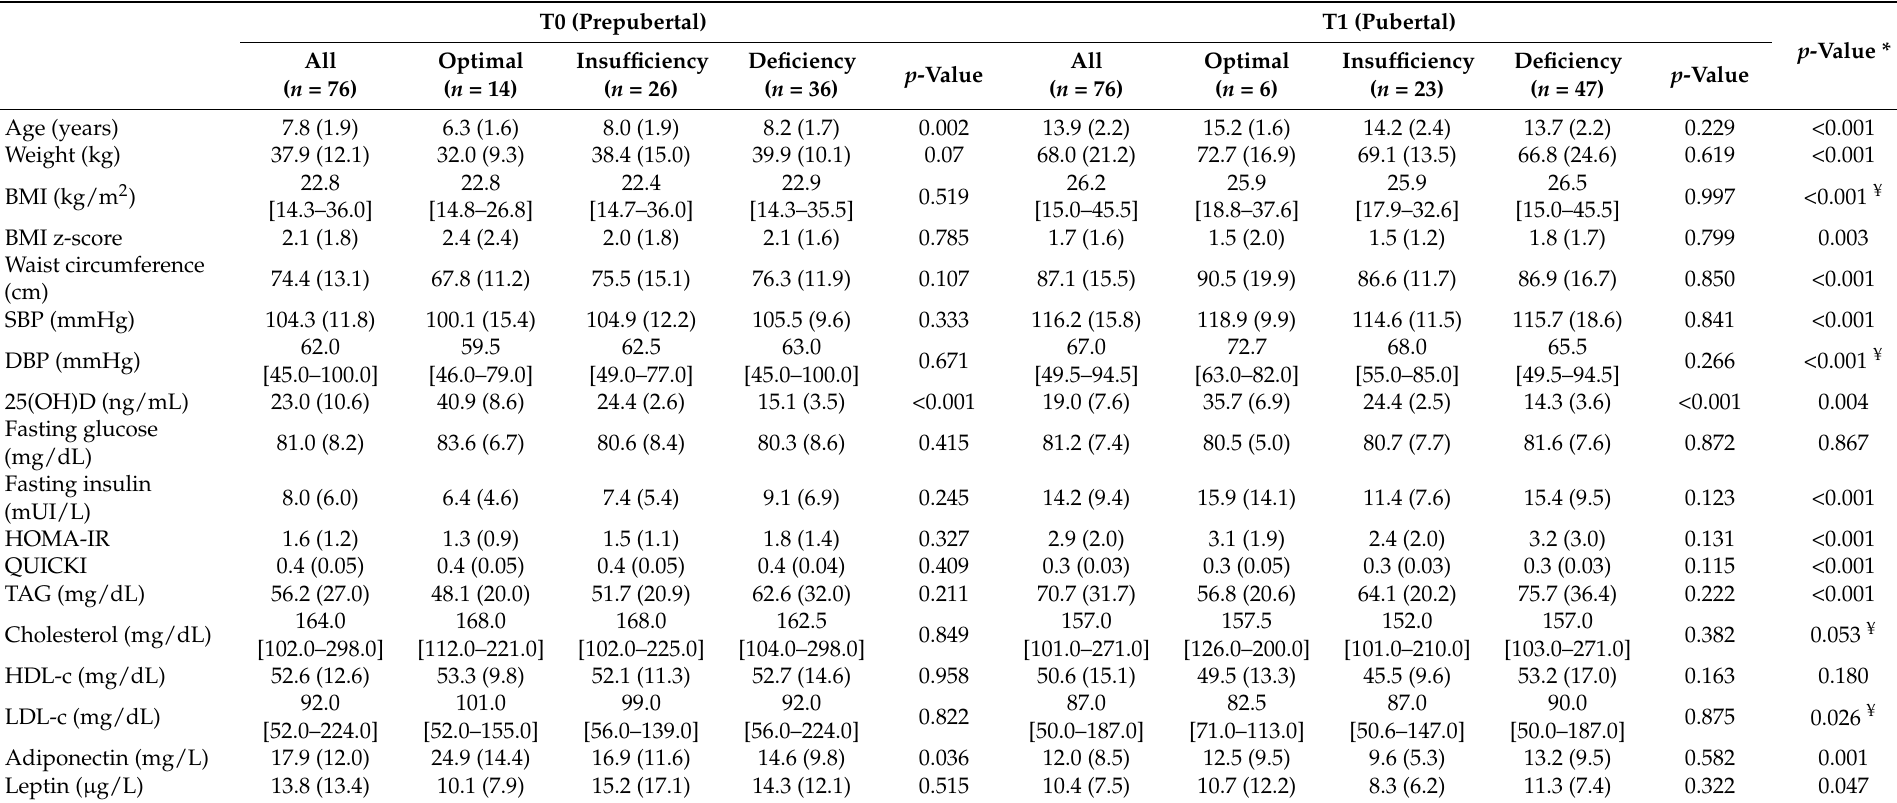
Table 1. Characteristics of the participants at baseline (prepubertal) and at the follow-up (pubertal) according to vitamin D